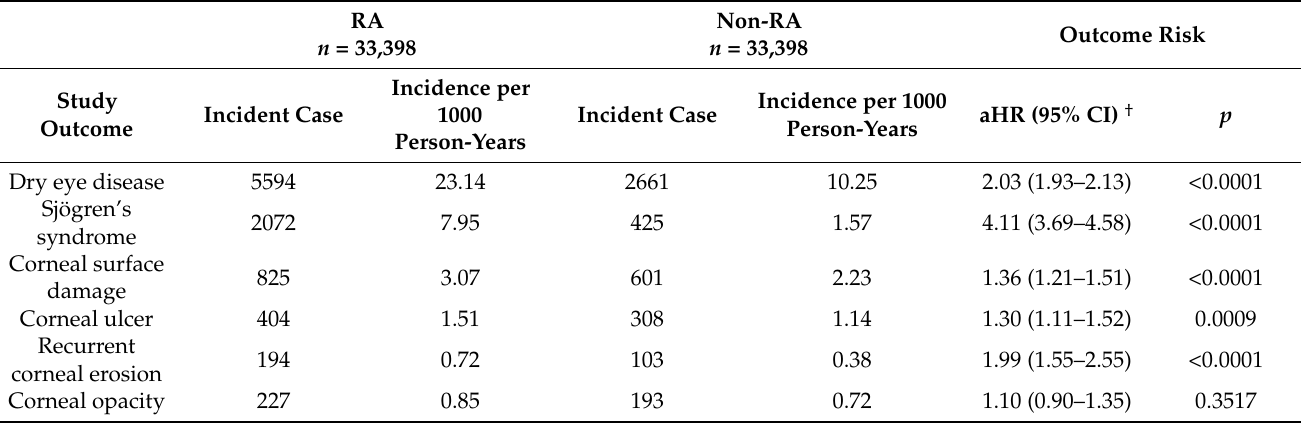
Table 2. Risk of dry eye disease and corneal surface damage for patients with and without rheumatoid